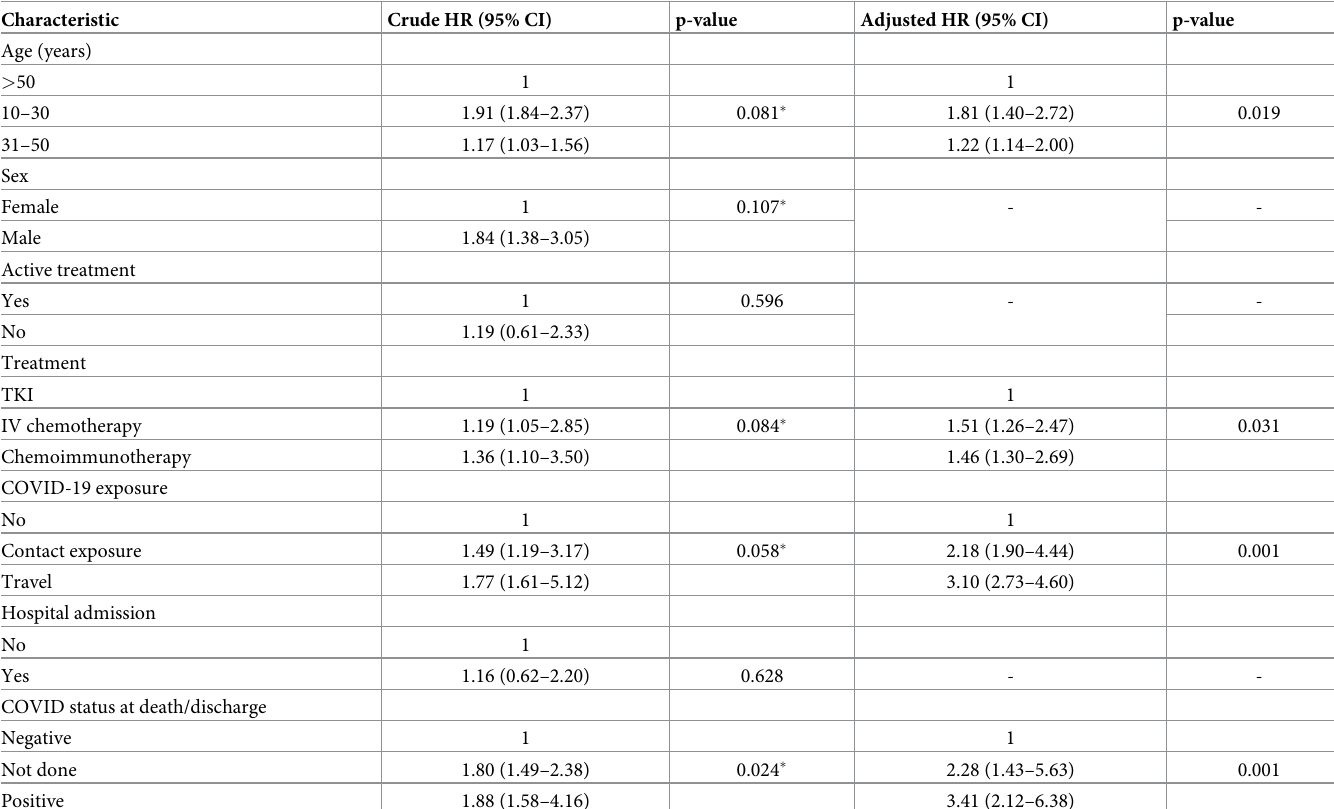
Table 4. Univariate and multivariable Cox-proportional hazard model reporting crude and adjusted ratios (n = 107).